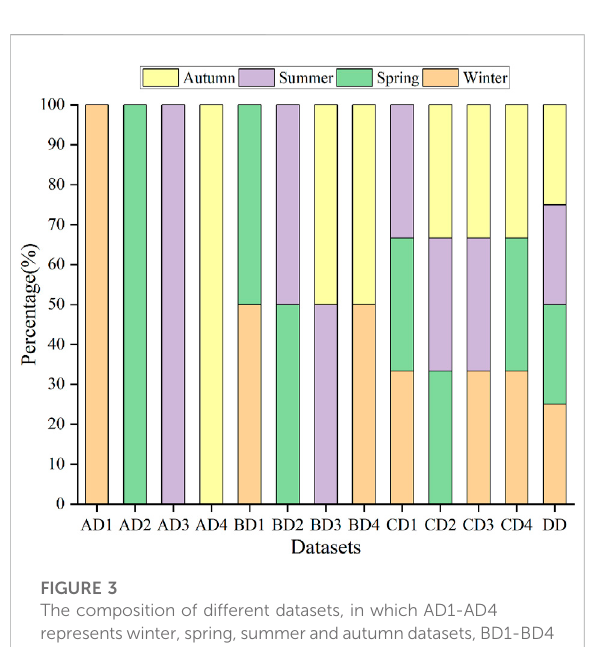
FIGURE 3 The composition of different datasets, in which AD1-AD4 represents winter, spring, summer and autumndatasets, BD1-BD4 represents winter/spring, spring/summer, summer/autumn and autumn/winter combined datasets, CD1-CD4 represents winter/spring/summer, spring/summer/autumn, summer/ autumn/winterandautumn/winter/springcombineddatasets,and DD represents all season combined